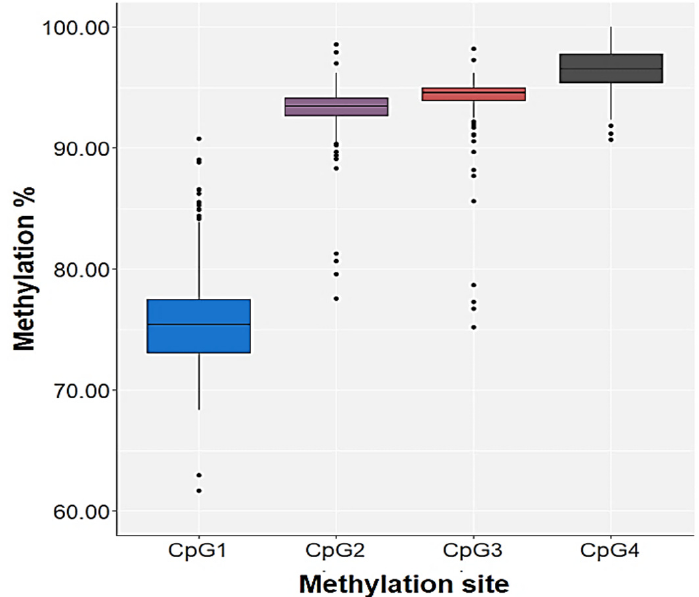
Figure 2. Methylation at four CpG sites of the HNF1A gene in all subjects. The central box represents the percentage of methylated cytosines (interquartile range), the middle line represents the median, the vertical line extends from the minimum to the maximum value and separate dots represent